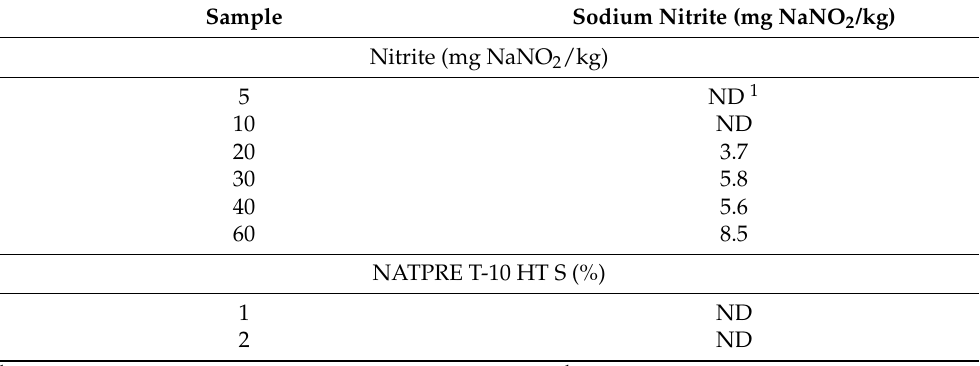
Table 1. Residual sodium nitrite content determined by high-performance liquid chromatography with diode array detection